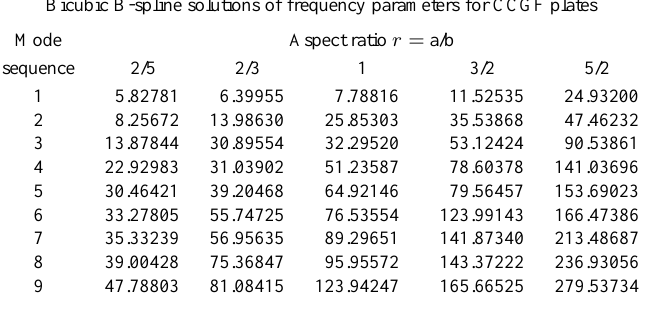
Table 8 Bicubic B-spline solutions of frequency parameters for CCGG